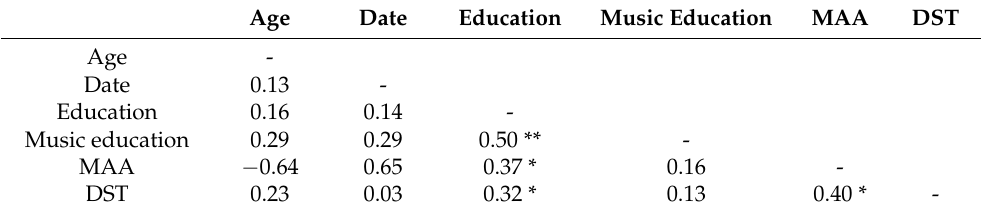
Table 5. Correlations between the demographic variables, MAA, and neurocognitive